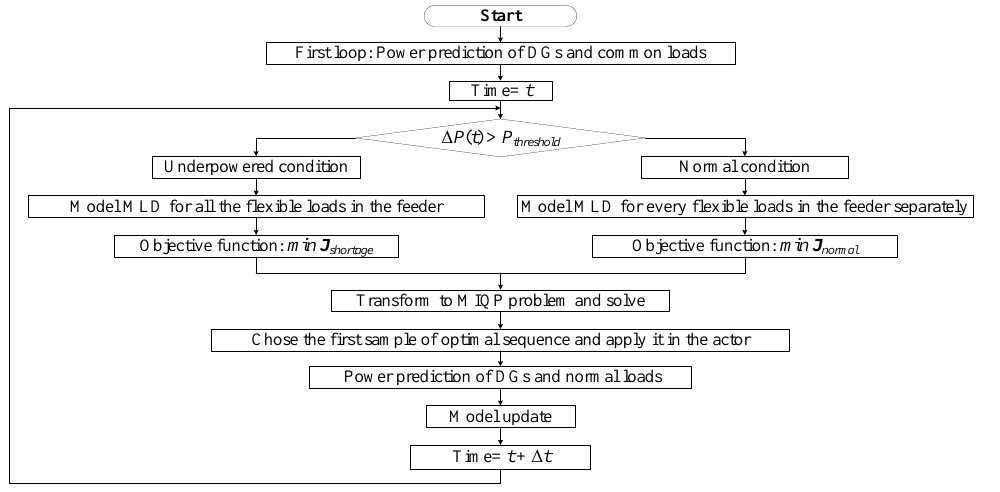
Figure 4. Block diagram of control of the ADN flexible loads.